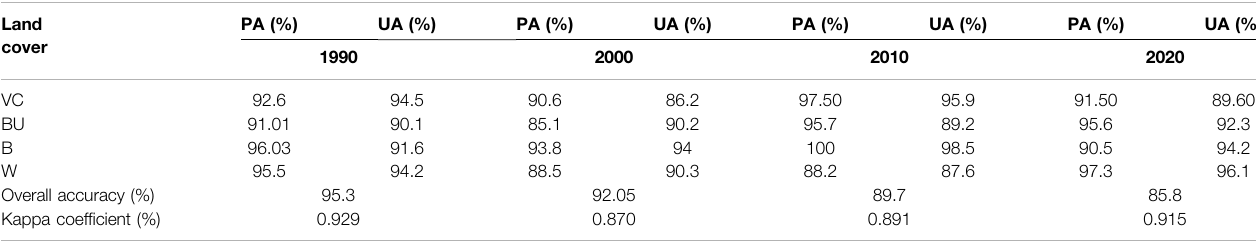
TABLE 2 | Summary of classi fi cation accuracy. Land